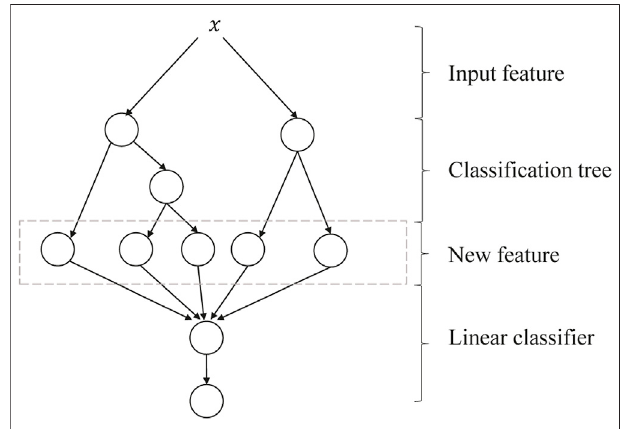
FIGURE 5 | Algorithm structure of GBDT + LR. GBDT, Gradient Boosting Decision Tree; LR, logistic